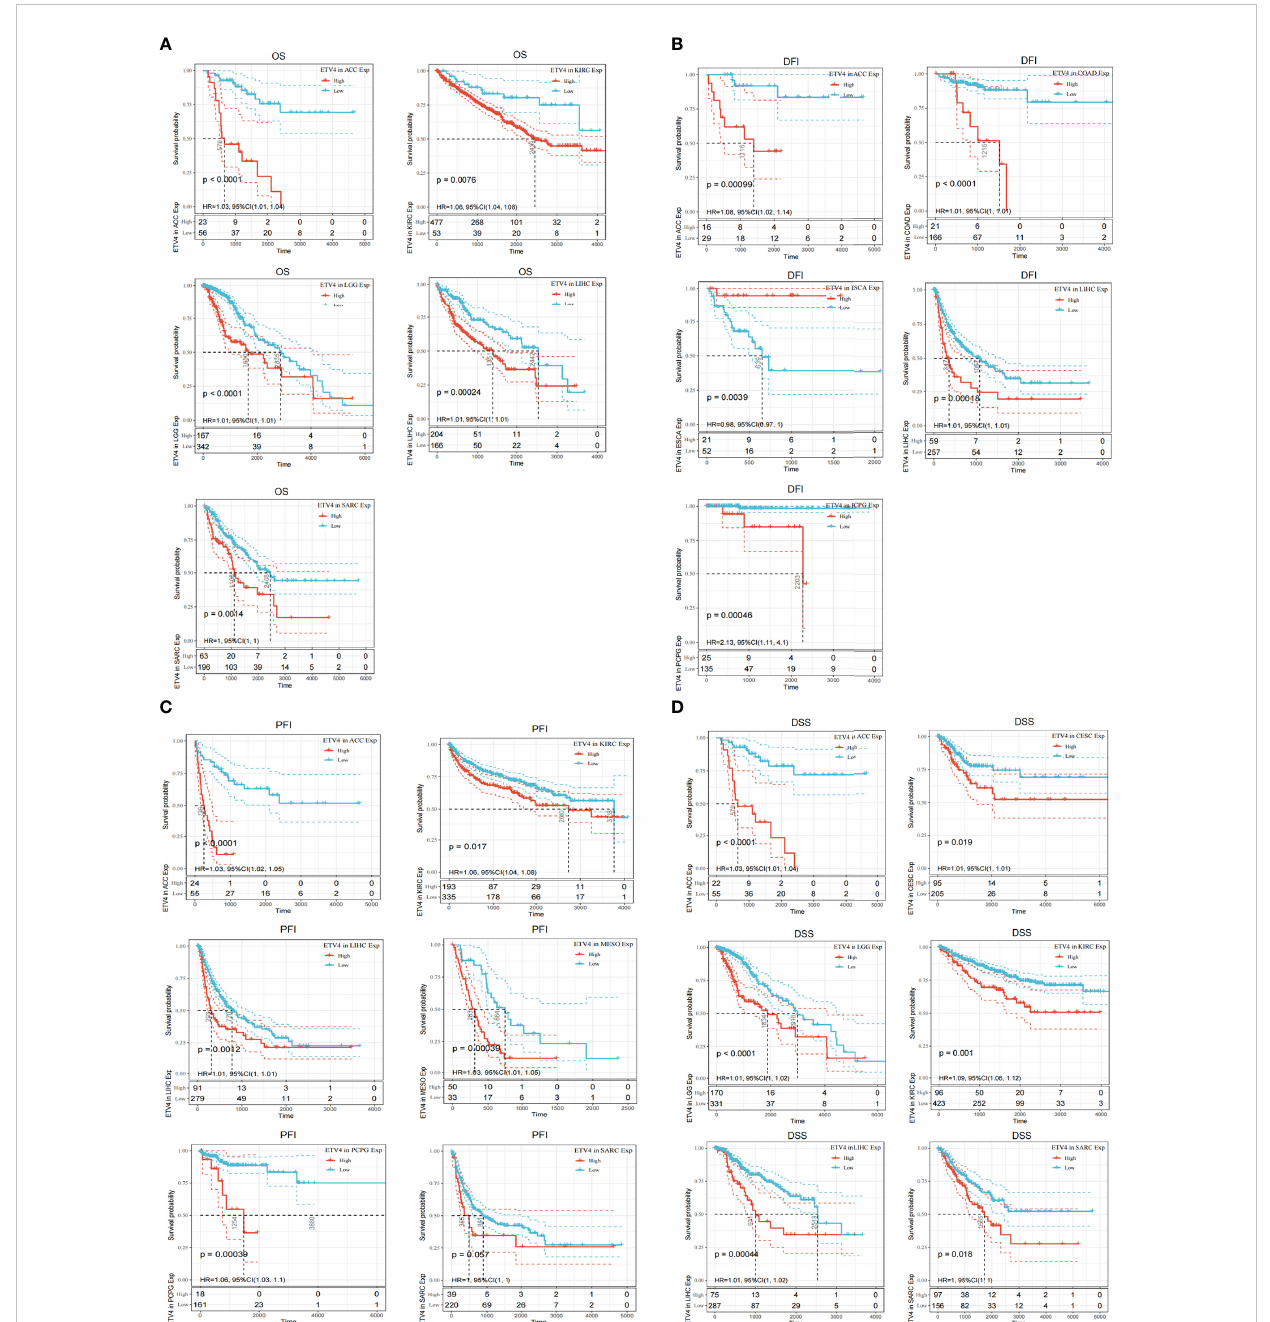
FIGURE 3 Kaplan-Meier analyses of the correlation between ETV4 expression and overall survival. (A) ,disease-free interval (B) , progression-free interval (C) , and disease-speci fi c survival (D) in various cancer